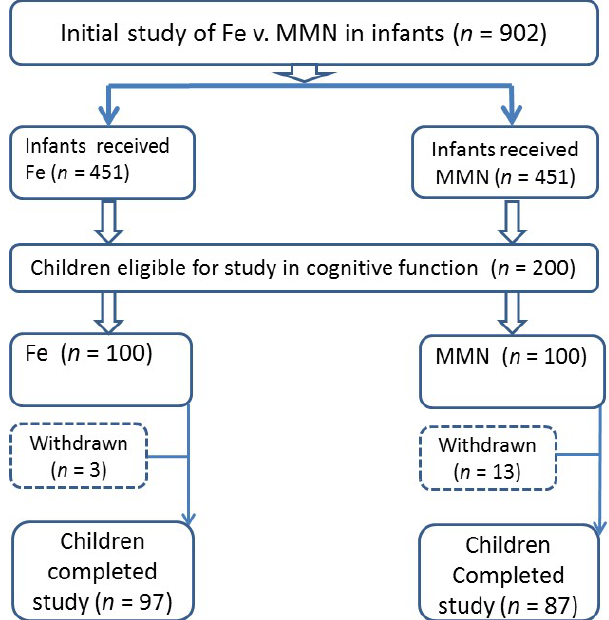
Figure 1. Study Figure 1. Study design.